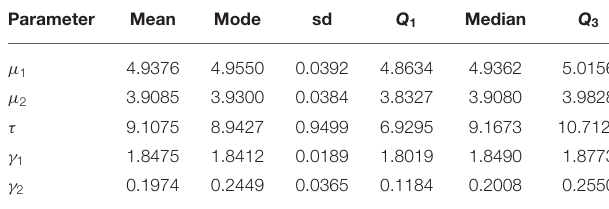
TABLE 5 | Bayes estimates of parameters based on scenario 3 with prior parameters µ 0